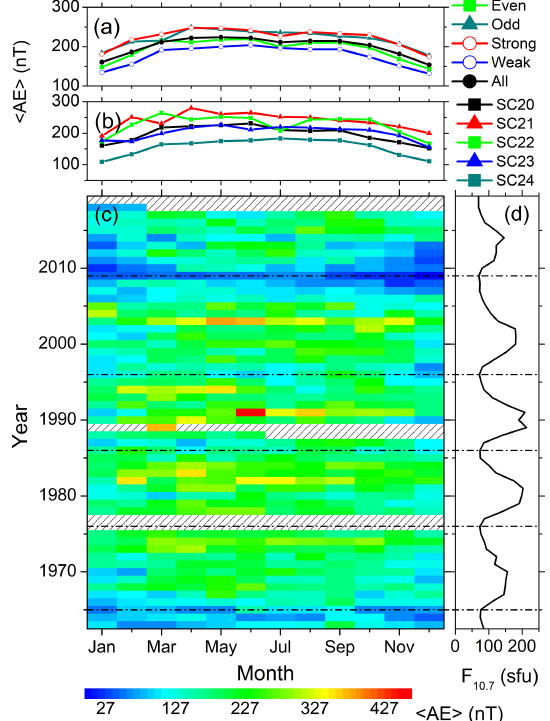
Figure 9. Geomagnetic AE index variation from 1963 to 2019. The panels are in the same format as in Fig.